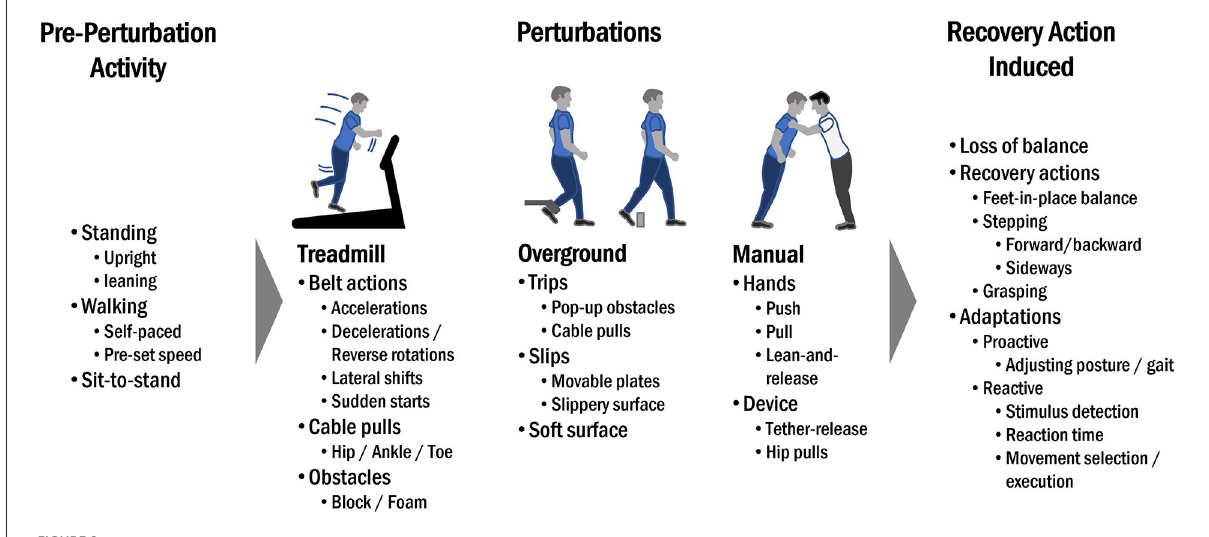
FIGURE2 Examples of various task-specific elements to consider in